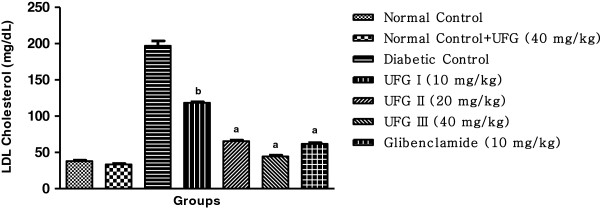
Effect of umbelliferone β-D-galactopyranoside on level of LDL (Low density lipoprotein) cholesterol at different concentrations on STZ induced diabetic rats, compared to diabetic control group rats; values are mean ± SEM; n = 6;
c
P < 0.05;
b
P < 0.01;
a
P < 0.001; P > 0.05 is considered as non-significant (ns).